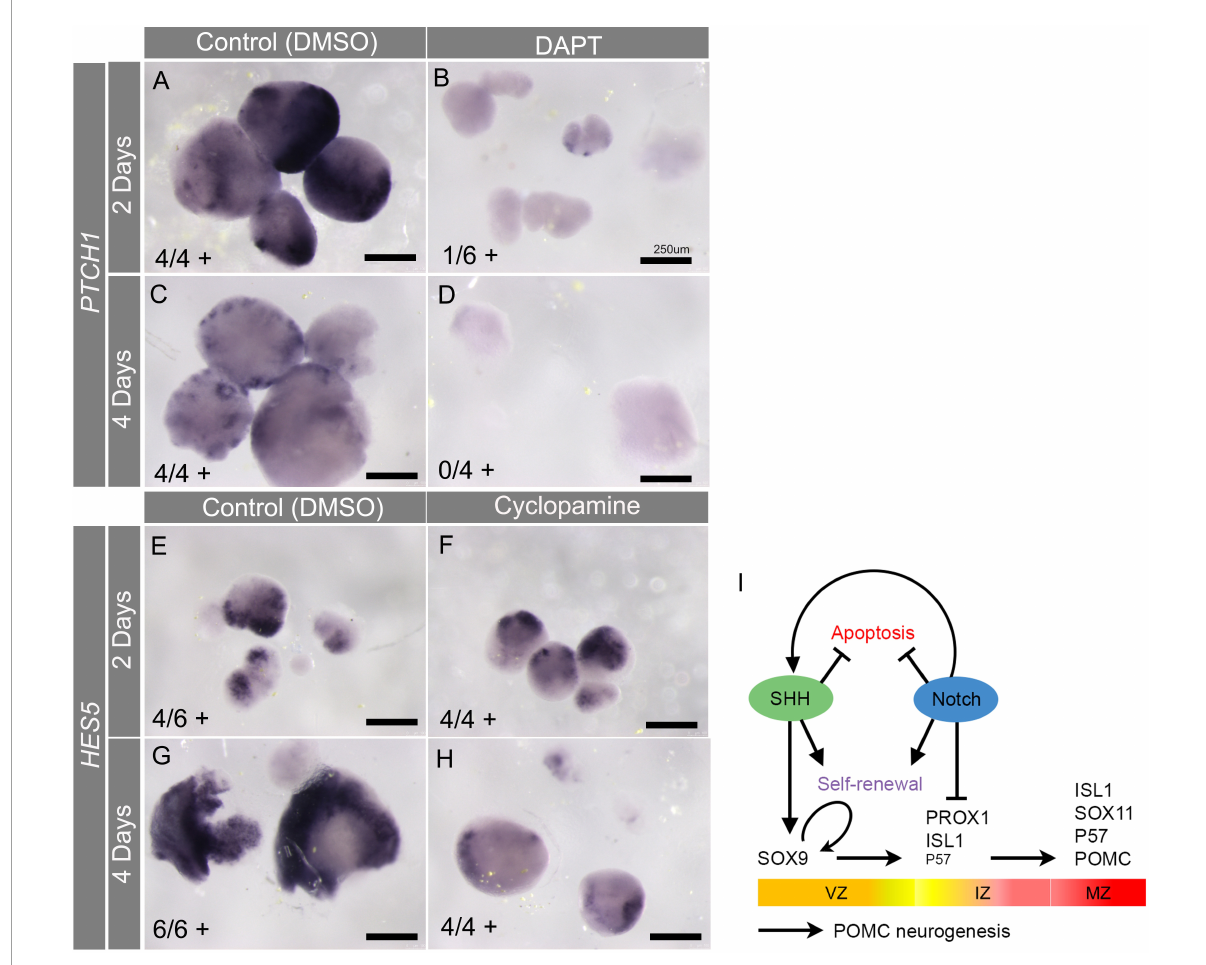
FIGURE7 (A–H) Results of ex vivo culture experiments on pHyp explants cultured in the presence of DMSO (A,C,E,G) , the Notch inhibitor DAPT (B,D) , or the SHH inhibitor cyclopamine for 2 (A,B,E,F) or 4 (C,D,G,H) days. Explants were processed by colourimetric in situ hybridisation for PTCH1 (A–D) or HES5 (E–H) mRNA. Numbers in brackets indicate the number of explants staining positively, and the total number of explants analysed. (I) Schematic summarising transcription factor expression over the course of POMC neurogenesis. Proposed roles of SHH signalling in inducing SOX9 expression, and of Notch signalling in inhibiting differentiation of IZ PROX1+ cells, are indicated. Hypothetical scenario is indicated, whereby SHH inhibits apoptosis directly, and Notch indirectly, by facilitating SHH signalling. Curved arrow indicates self-renewal of SOX2+/SOX9+ VZ progenitor cells. Horizontal arrows indicate temporal progression of POMC neurogenesis. VZ, ventricular zone; IZ, intermediate zone; MZ, mantle